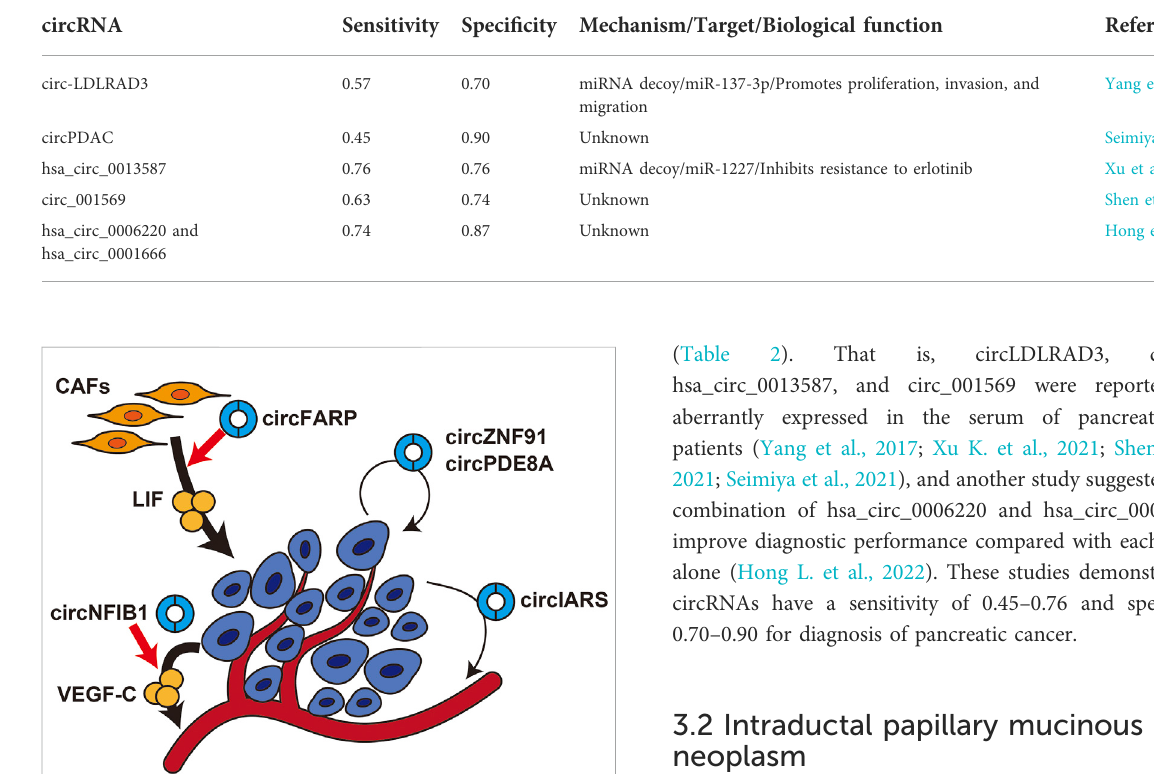
FIGURE 2 Effects of circRNAs on the tumor microenvironment in pancreatic cancercircFARP enhances LIF expression in cancer- associated fi broblasts. circNFIB1 enhances VEGF-C expression in pancreatic cancer cells. circZNF91 and circPDE8A are transmitted from pancreatic cancer cells to nearby cancer cells. circIARS is transmitted from pancreatic cancer cells to endothelial